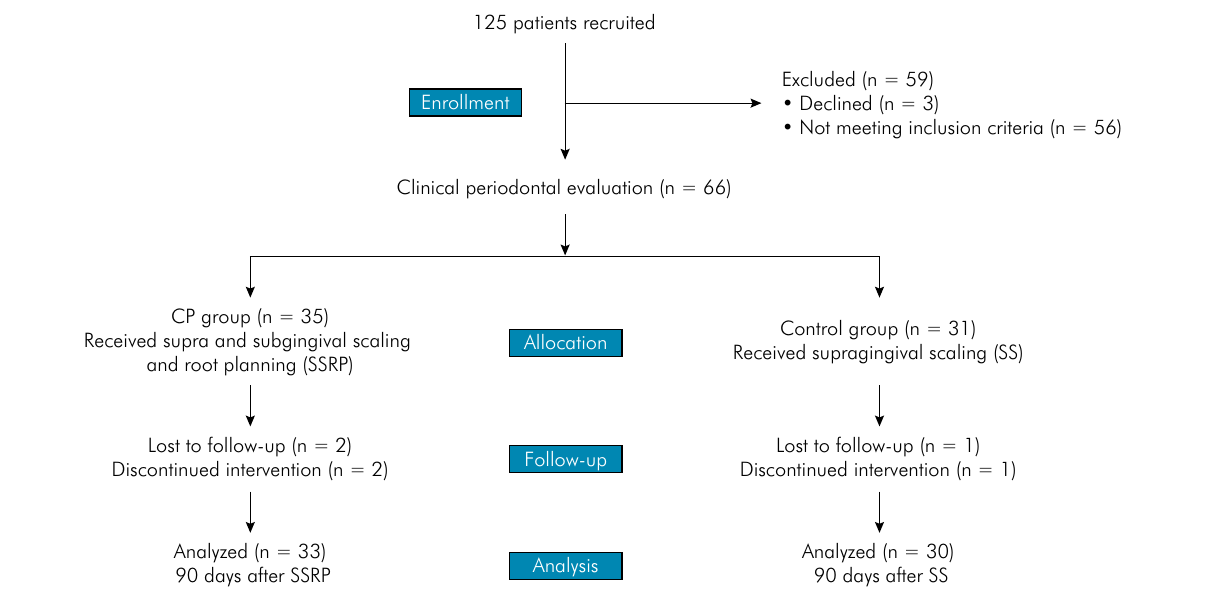
Figure. Flowchart of study